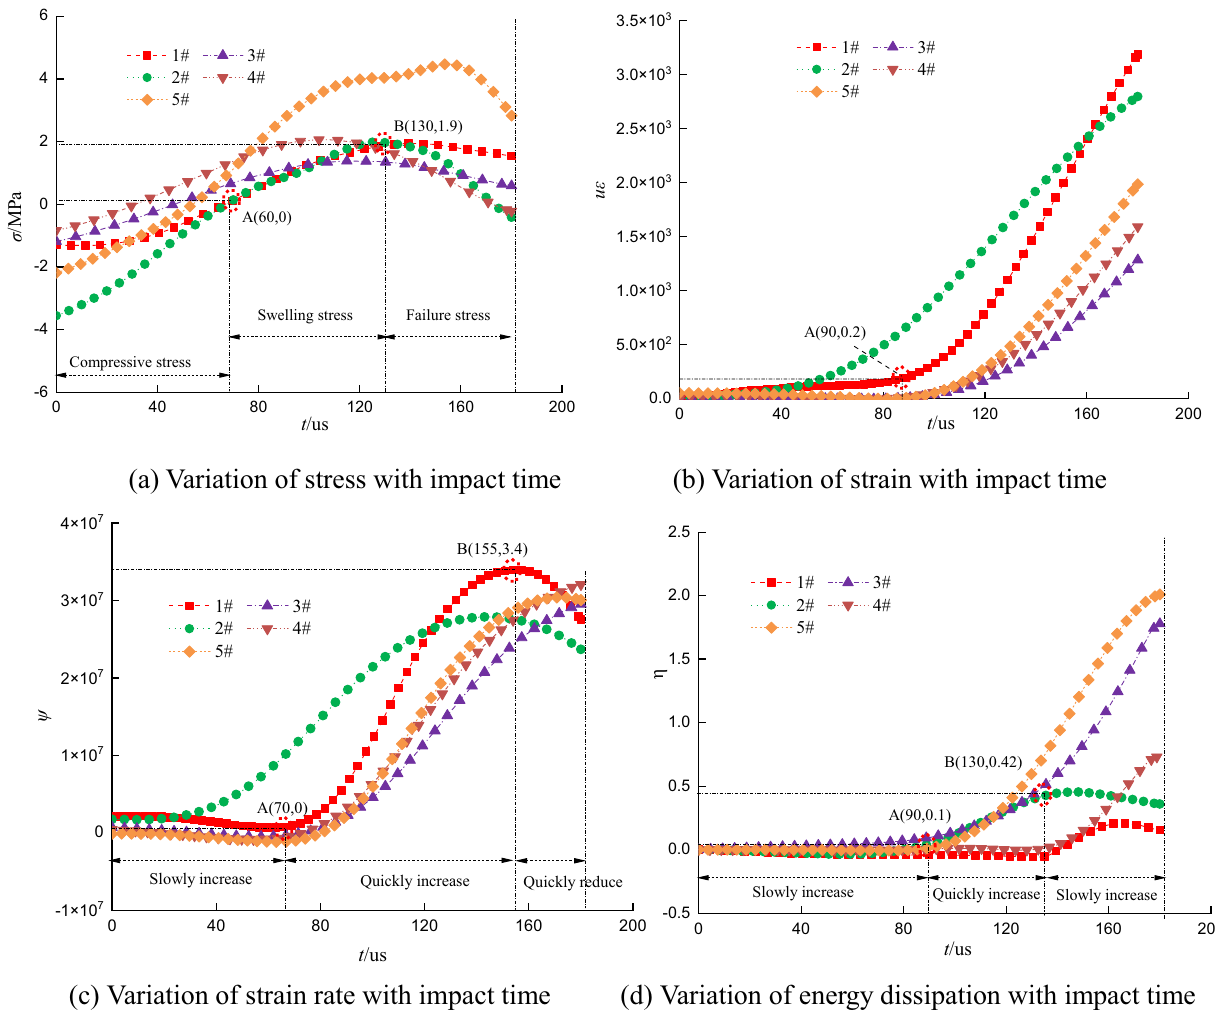
Fig. 4 Dynamic mechanical characteristics of coal with a water content of 60%. a Variation of stress with impact time; b Variation of strain with impact time; c Variation of strain rate with impact time; d Variation of energy dissipation with impact